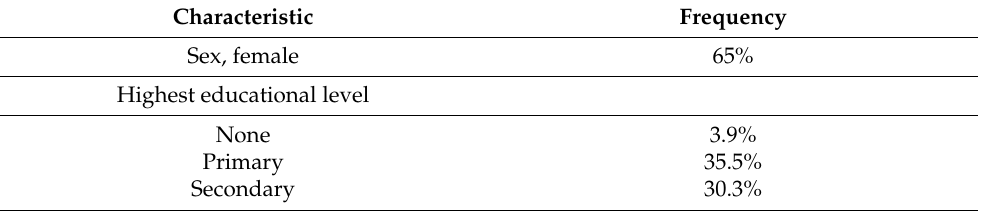
Table 1. Sociodemographic and family profile in patients with type 2 diabetes treated in primary care ( n =